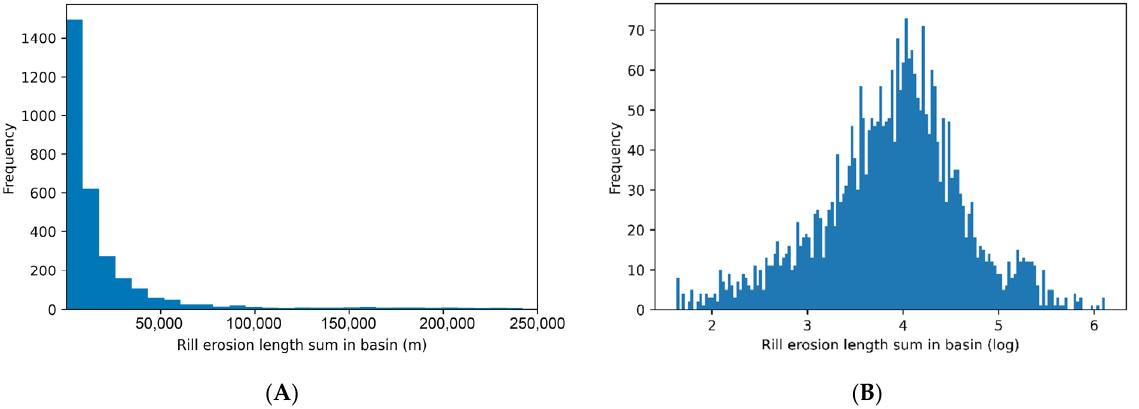
Figure 8. Distribution of total rill erosion length (m) ( A ) and normalized distribution of total rill erosion length ( B ).